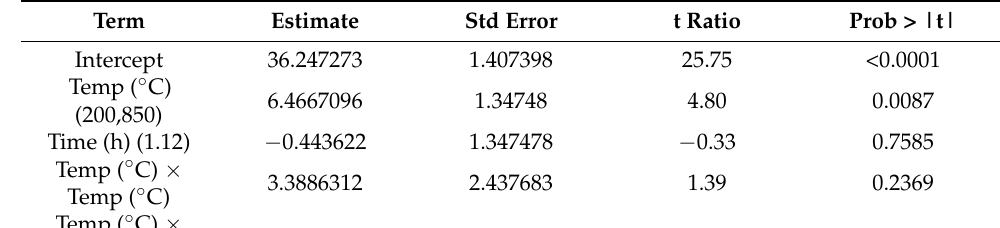
Table 10. Parameter estimates for K1-based samples.